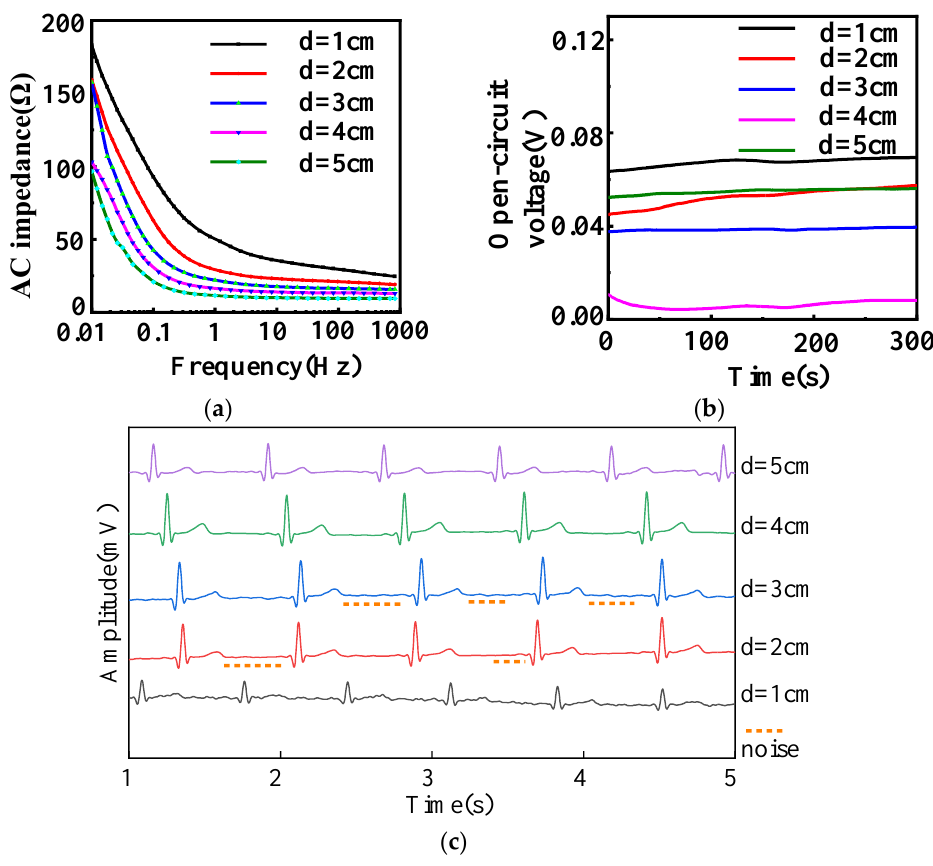
Figure 3. ( a ) AC impedance, ( b ) open-circuit voltage, and ( c ) static ECG signals of different diameters with 12/5 sateen and 35 picks/cm for fabric electrodes. (d represents the diameter). The equivalent circuit of AC impedance for a pair of fabric electrodes is shown in Figure 4. The fabric electrode can be modeled as a parallel circuit described by an equiva- lent AC impedance ( Z ), which is composed of the resistance of the fabric electrode ( R t ) and the electric double-layer capacitor between the fabric electrode and the sodium chlo- ride solution ( C t ). The resistance of the sodium chloride solution (R e ) is negligible.